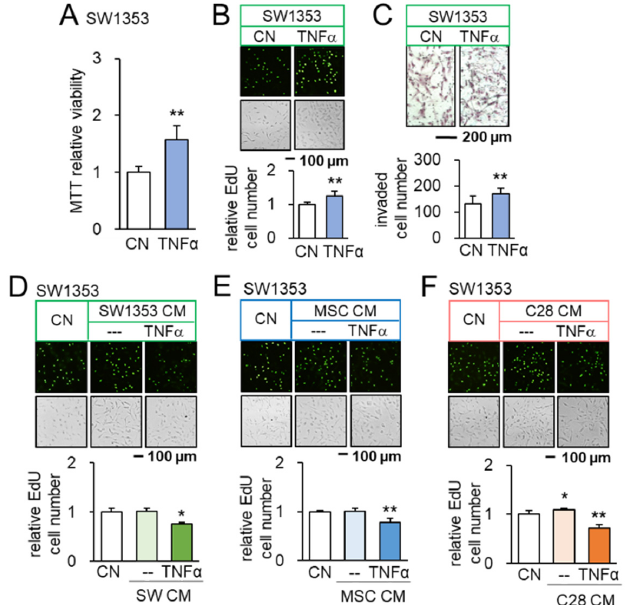
Figure 1. Opposing effects of TNF α and TNF α -treated CM on SW1353 CS cells. CN = control, CM = conditioned medium, and C28 = C28/I2 chondrocytes. The single and double asterisks indicate p < 0.05 and 0.01, respectively. ( A – C ) Increase in MTT-based viability, EdU-based proliferation, and transwell invasion of SW1353 cells in response to 10 ng/mL of TNF α ( n = 6). ( D ) Upregulation of Runx2 and Snail in SW1353 cells by 10 ng/mL of TNF α ( n = 6). ( E , F ) Reduction in EdU-based proliferation of SW1353 cells by TNF α -treated CS cells, MSC, and C28 chondrocyte-derived CMs, respectively ( n = 6). The concentration of TNF α was 10